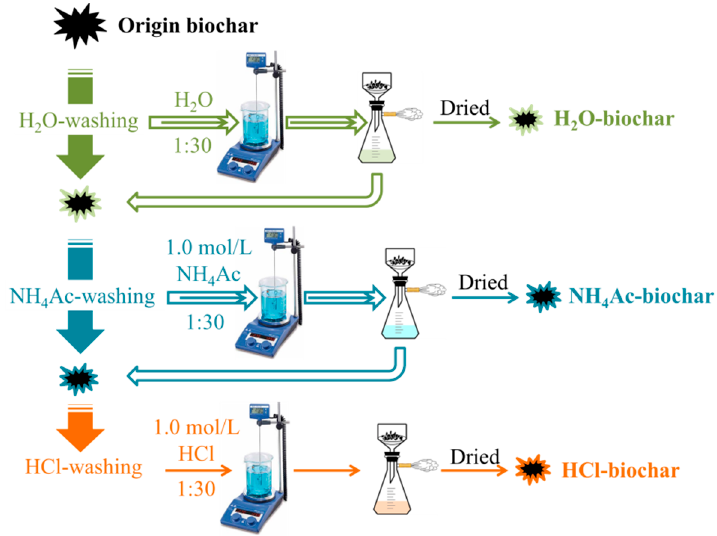
Figure 2. Schematic of the chemical fractionation analysis of biochar.